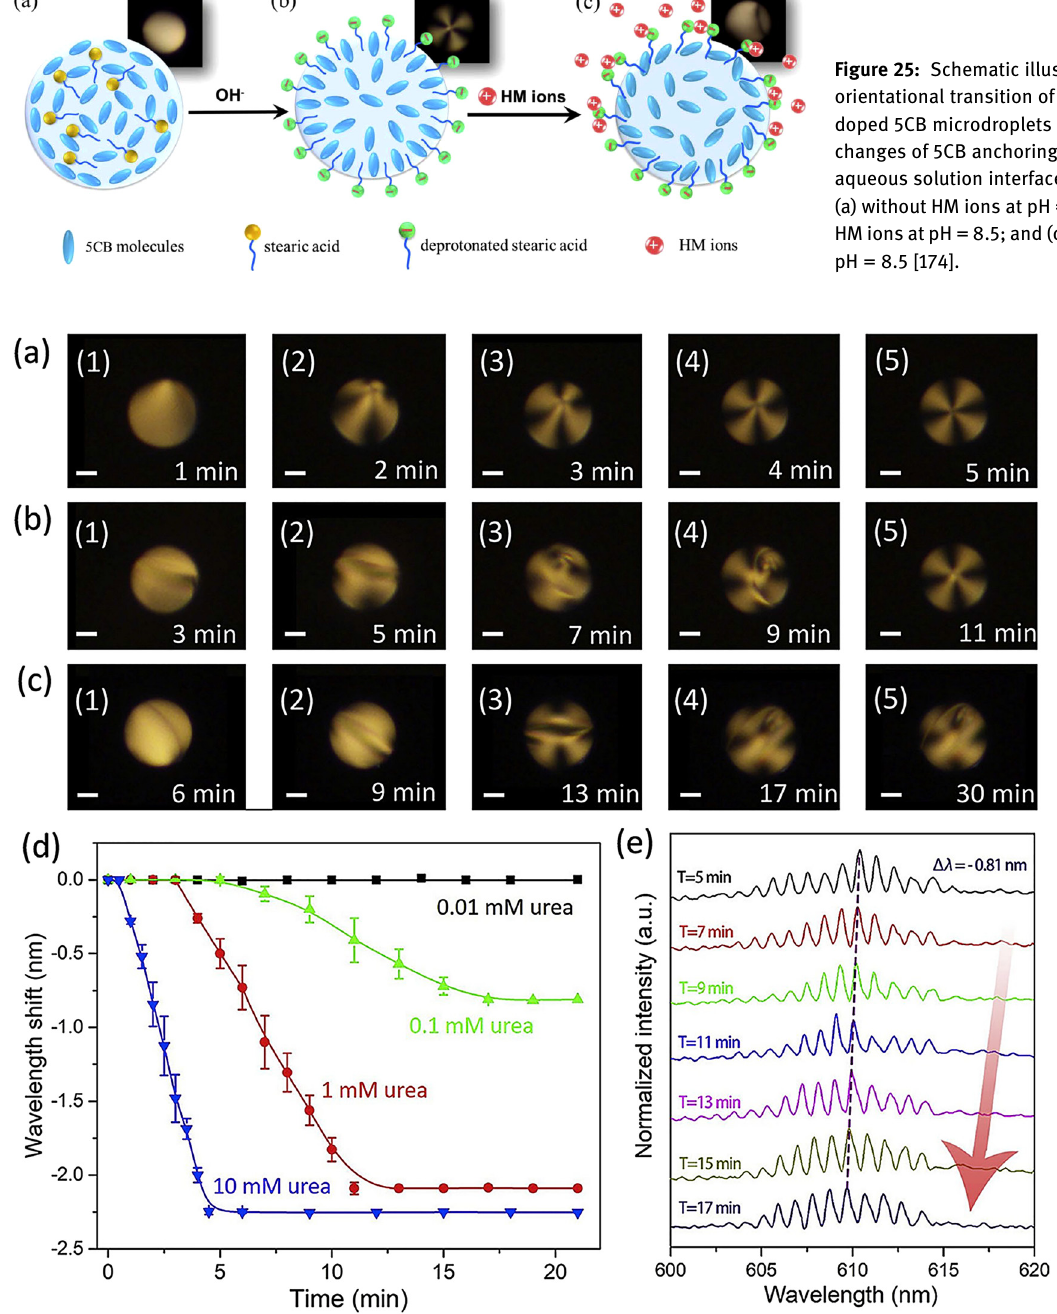
Figure 26: POMimages of 65- μ m-diameter acid-doped 5CB microdroplets in PBS (pH = 7) containing 0.1 mg/ml urease after addition of 40 μ L of 10 mM (a), 1 mM (b), 0.1 mM (c) urea. Scale bars 20 μ m. (d) Temporal dependence of WGM wavelength shift with different urea concen- trations.(e)PortionofWGMlasingspectraasafunctionoftime.Spectrawerecollectedfroma65- μ